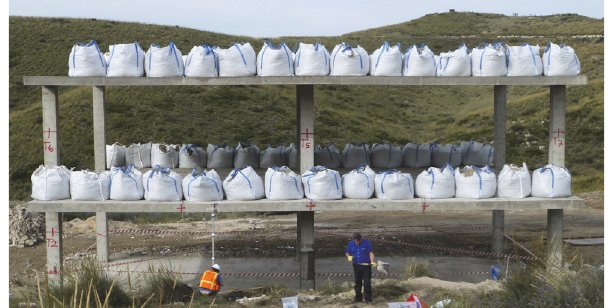
Figure 1: Photograph of the studied structure.